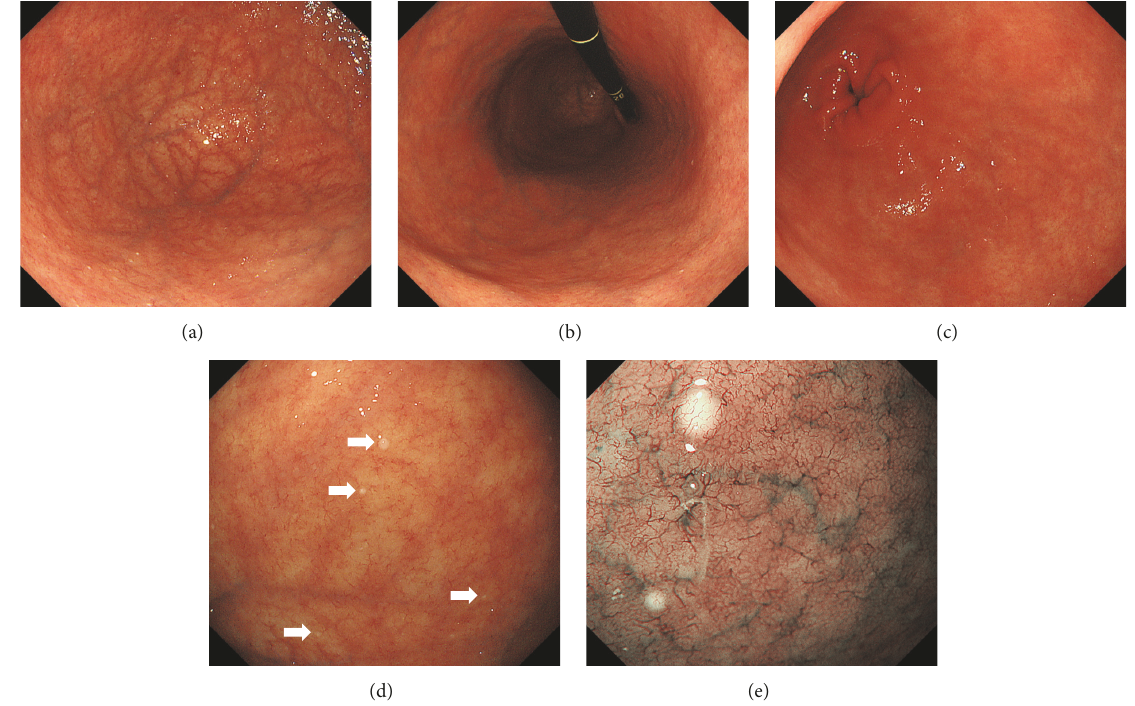
Figure 1: Esophagogastroduodenoscopy images of Case 1. Atrophy is predominantly observed in the gastric fornix (a) and body (b), while it is not evident in the antrum (c). Close-up observation of the gastric fornix shows multiple white substances (d). Magnifying observation with narrow-band imaging reveals microvasculature on its surface (e).